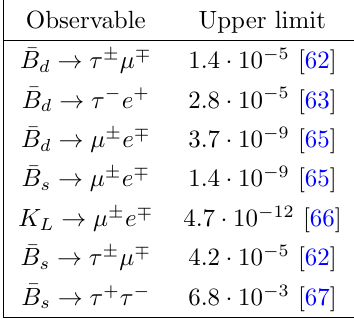
Table 5 . Experimental measurements of semileptonic LFV